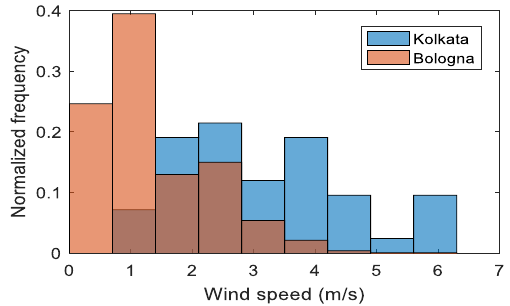
Figure 8. Distribution of wind speed during rain events.